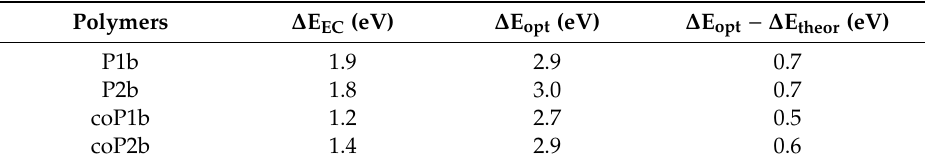
Table 4. Energy bandgaps calculated using voltammetric ( ∆ E EC ) and optical ( ∆ E opt ) data, compared to the relative di ff erence with the theoretical C1b and C2b HOMO-LUMO values ( ∆ E opt − ∆ E theor ), reported in Table